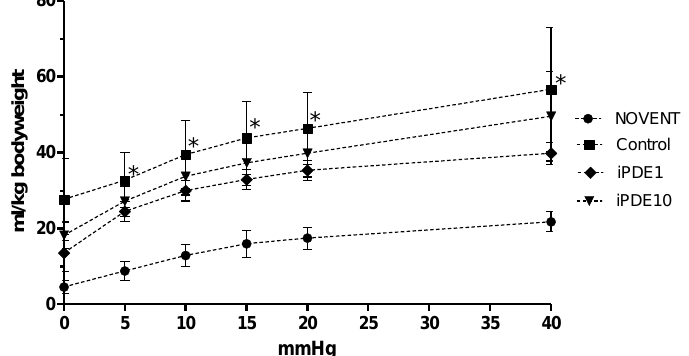
Figure 2. Normalized pressure-volume curve in animals of the NOVENT group ( • ), control group ( ■ ), iPDE1 group ( ♦ ) and iPDE10 group ( ▼ ), given as mean ± SEM (* p < 0.05 vs. NOVENT).